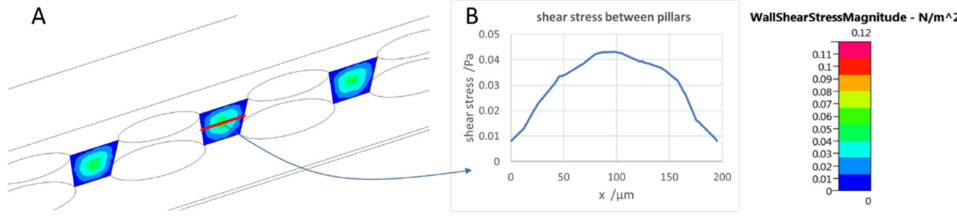
Figure A5. ( A ) Shear stress at the interface between gel phase and perfusion in the MFC determined by multi-physics simulation at a flow rate of 10 µ L/min in the luminal channel. ( B ) Shear stress varies between 0.01 and 0.045 Pa from the rim to the center of the gap between